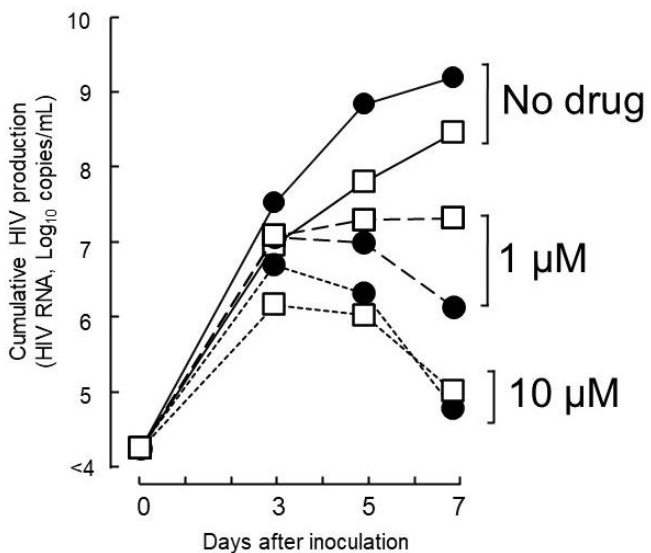
Figure 4. Anti-HIV activity of TFV against isolates without and with TDF-drug resistance-related mutations. The tested concentration of 1 µM corresponded to the C max value of TFV, and 10 µM is the highest IC 90 expected to significantly suppress the viral load of isolates without TDF drug resistance-related mutations ( ● DR1509-397) or with mutations ( ◻ DR1606-521). Abbreviations are as in Figure 2.